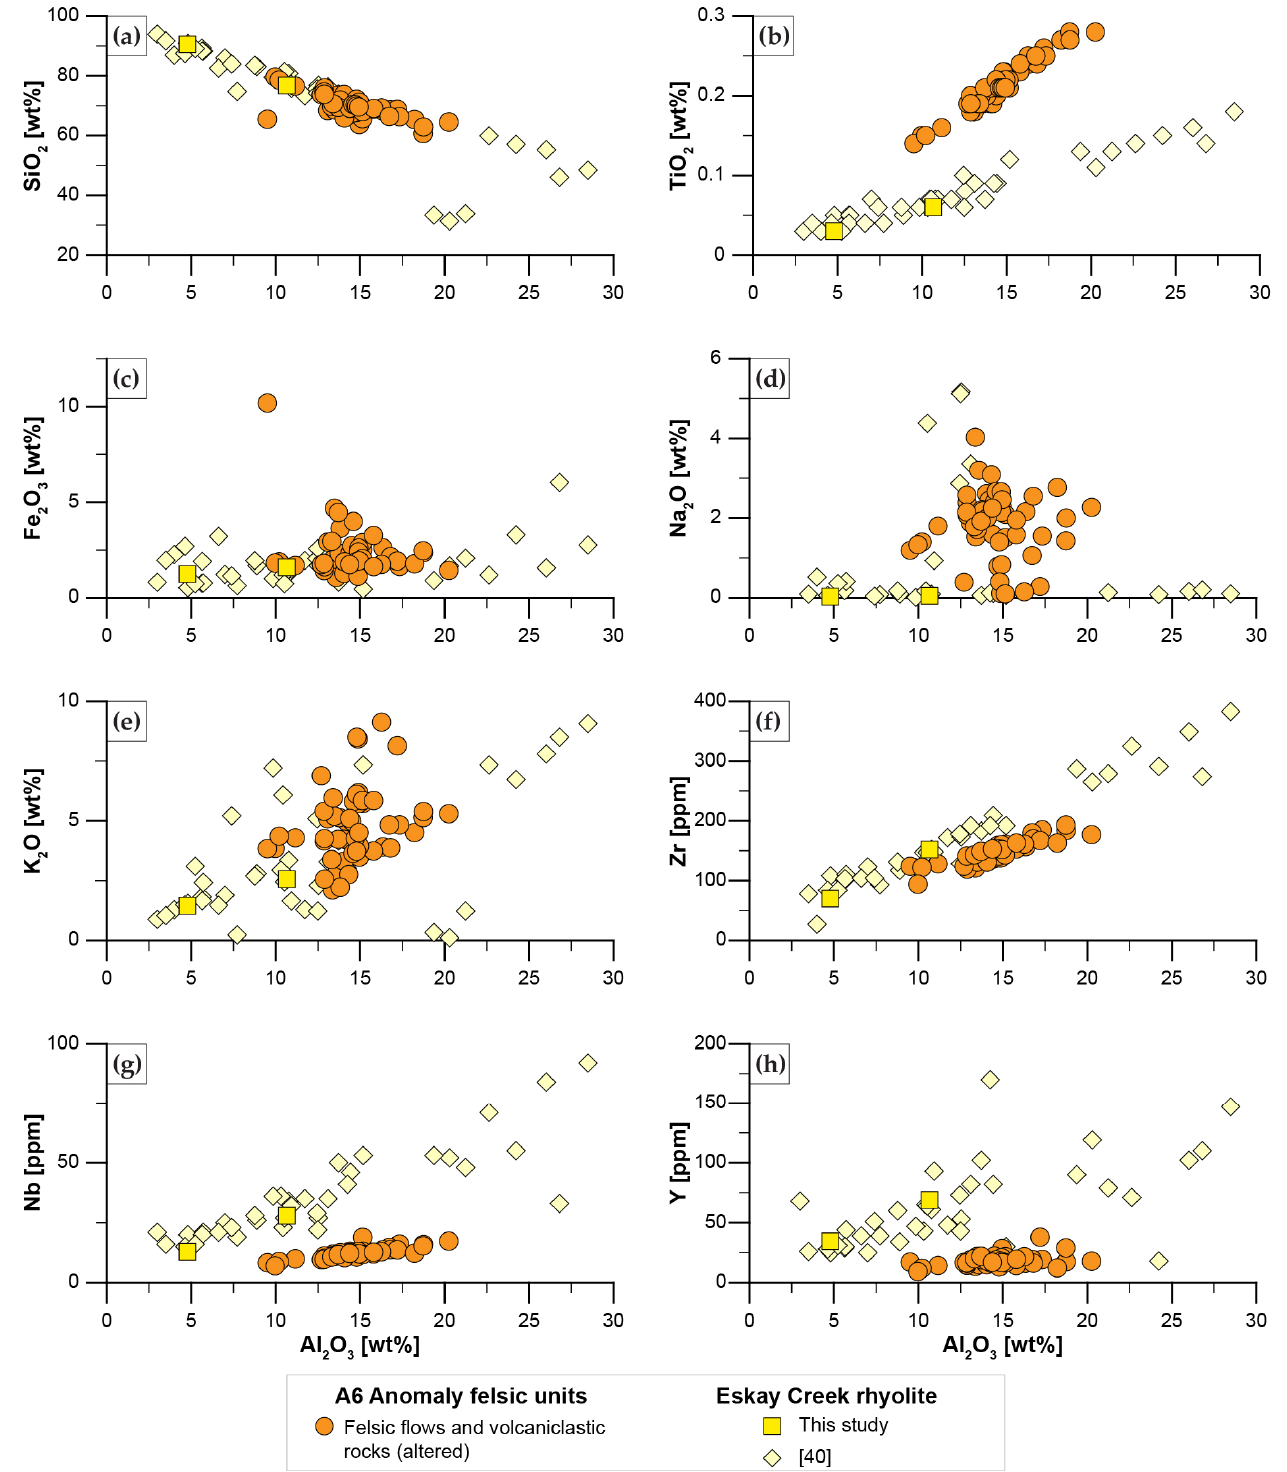
Figure 8. Bivariate plots of felsic flows and volcaniclastic lithologies from the A6 Anomaly and Eskay Creek (with data from [40] and this study) for selected major, minor and trace elements versus Al 2 O 3 [wt%]. ( a ) SiO 2 [wt%], ( b ) TiO 2 [wt%], ( c ) Fe 2 O 3 [wt%], ( d ) CaO [wt%], ( e ) K 2 O [wt%], ( f ) Zr [ppm], ( g ) Nb [ppm], ( h ) Y